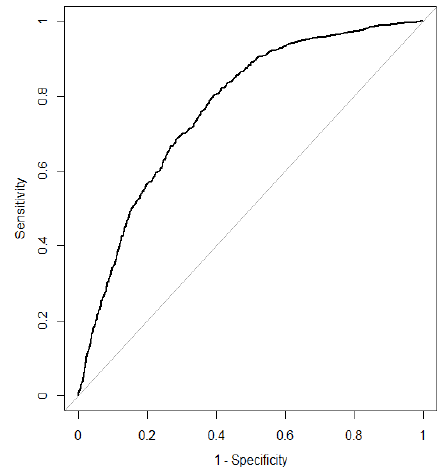
Figure 4. ROC curve for deep neural network (DNN) (Tanh). (AUC = 0.753, F-score = 0.721).